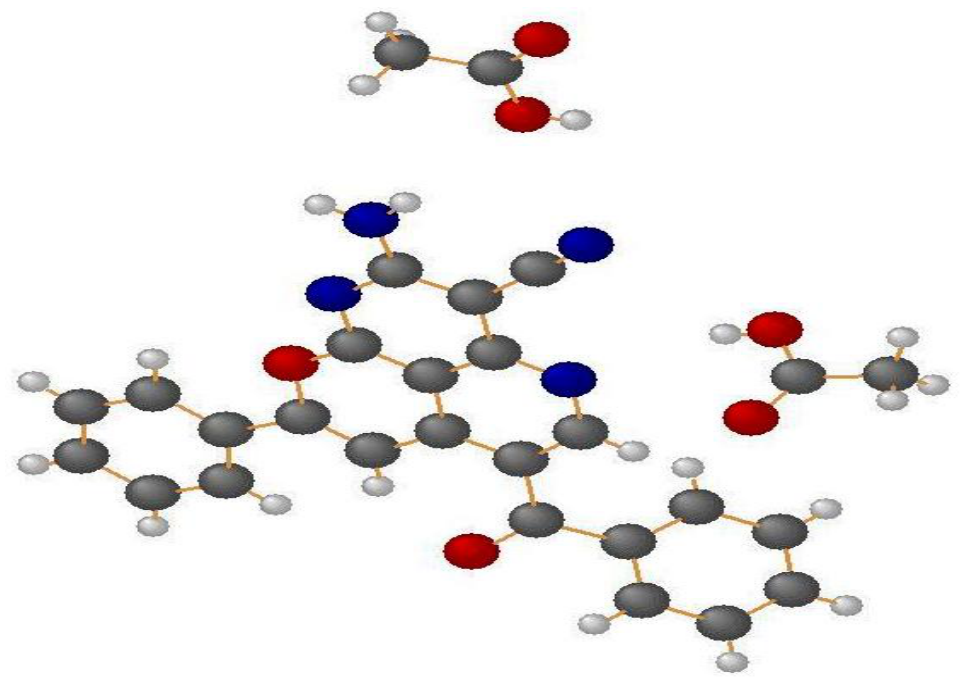
Figure 4. Crystal structure of 20c .